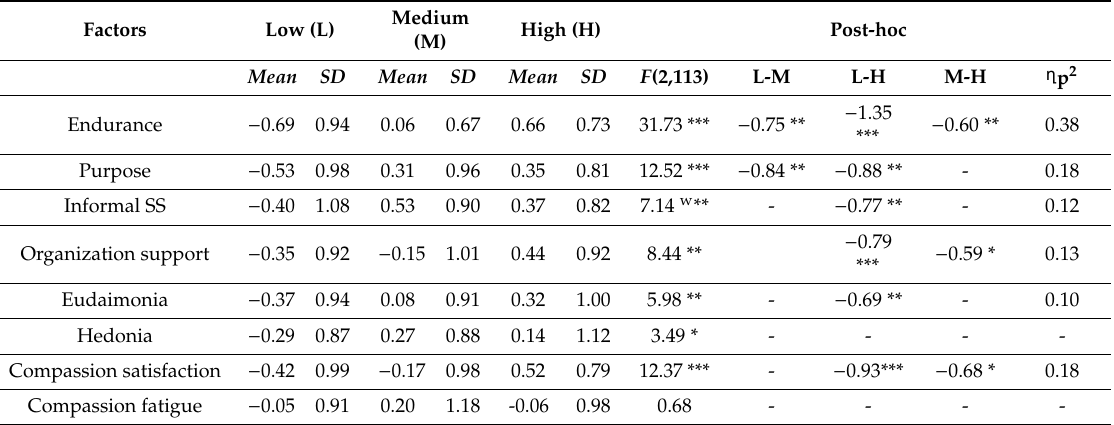
Table 2. ANOVA for contrasting volunteers with di ff erent levels of post-traumatic